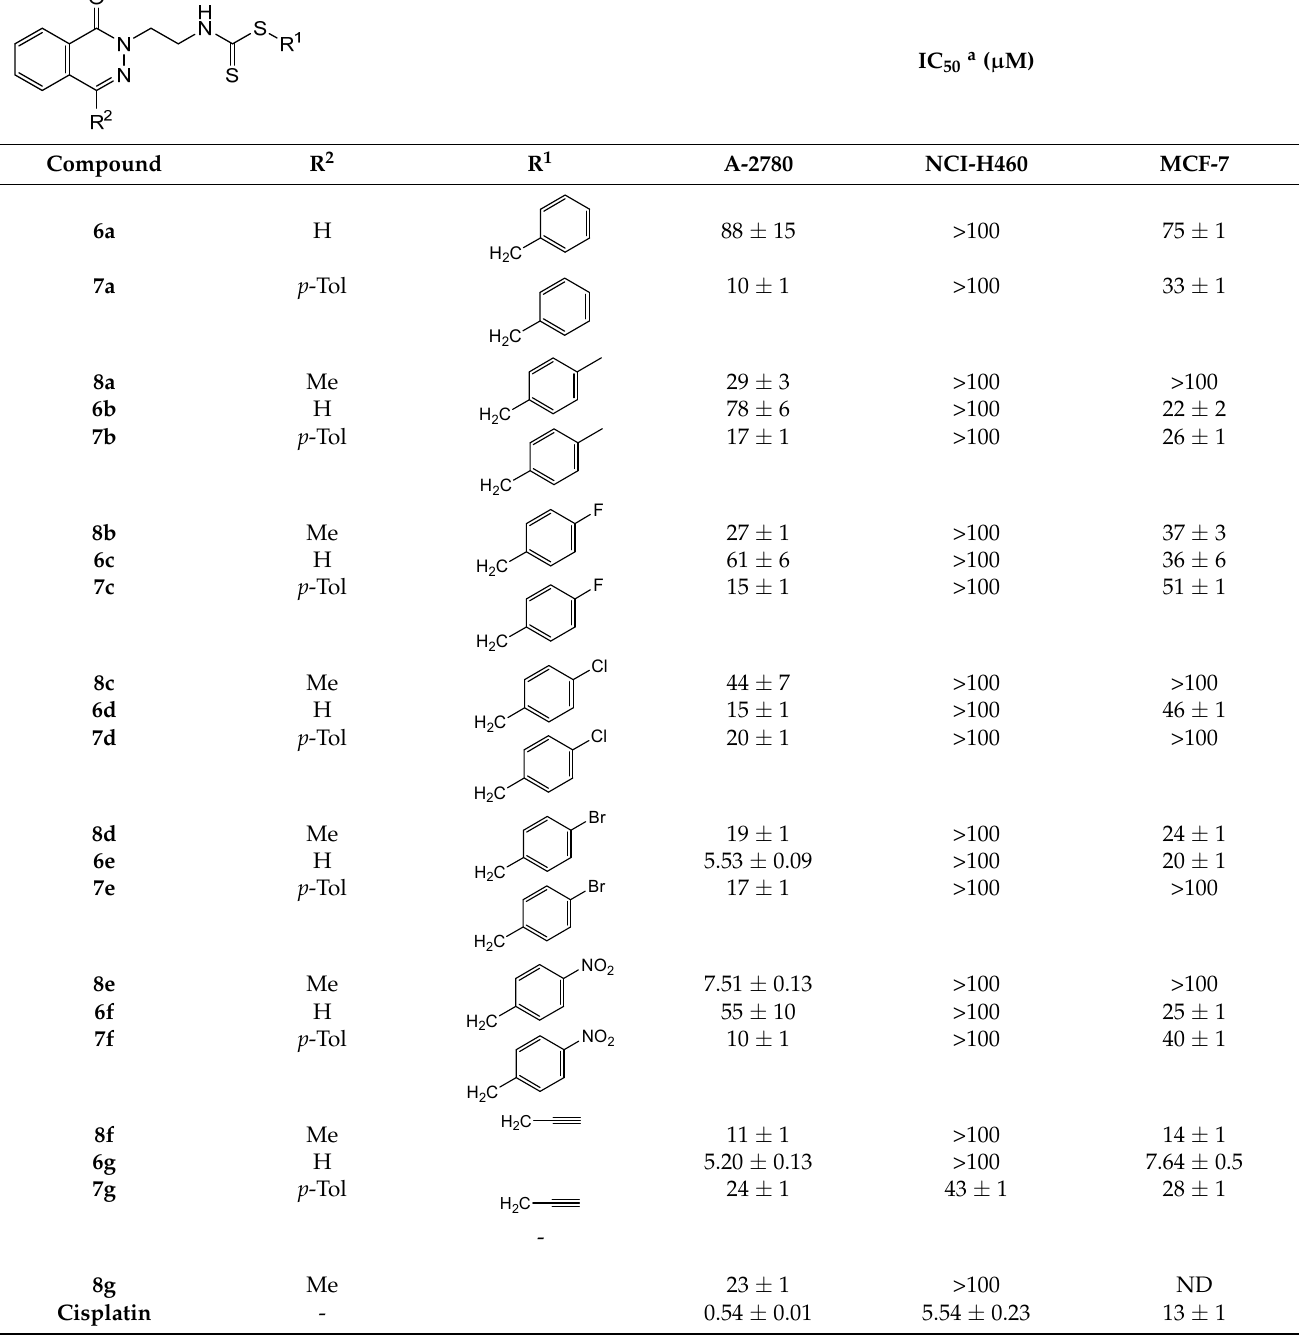
Table 1. Antiproliferative activity (IC 50 values) of phthalazinone-dithiocarbamate hybrid com- pounds 6a – g, 7a – g , and 8a – g against A-2780, NCI-H460, and MCF-7 cell lines.